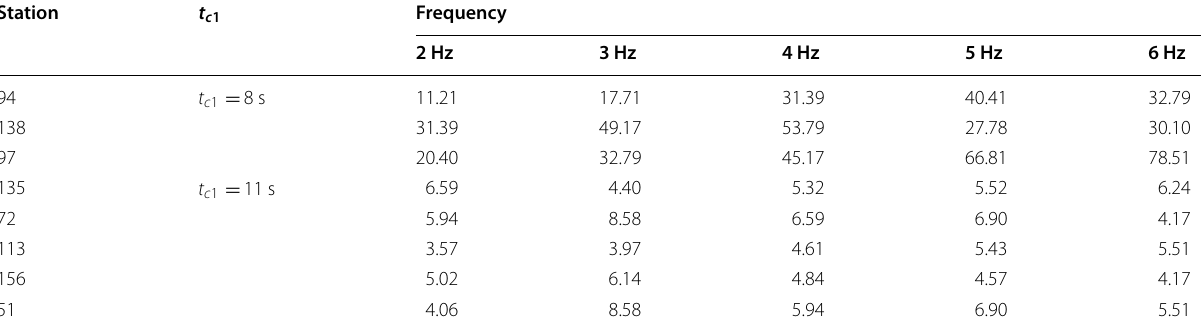
Table 1 The values of A c 1 ( f , t c 1 )/ A c ( f , t c = 17 s ) at different center frequencies